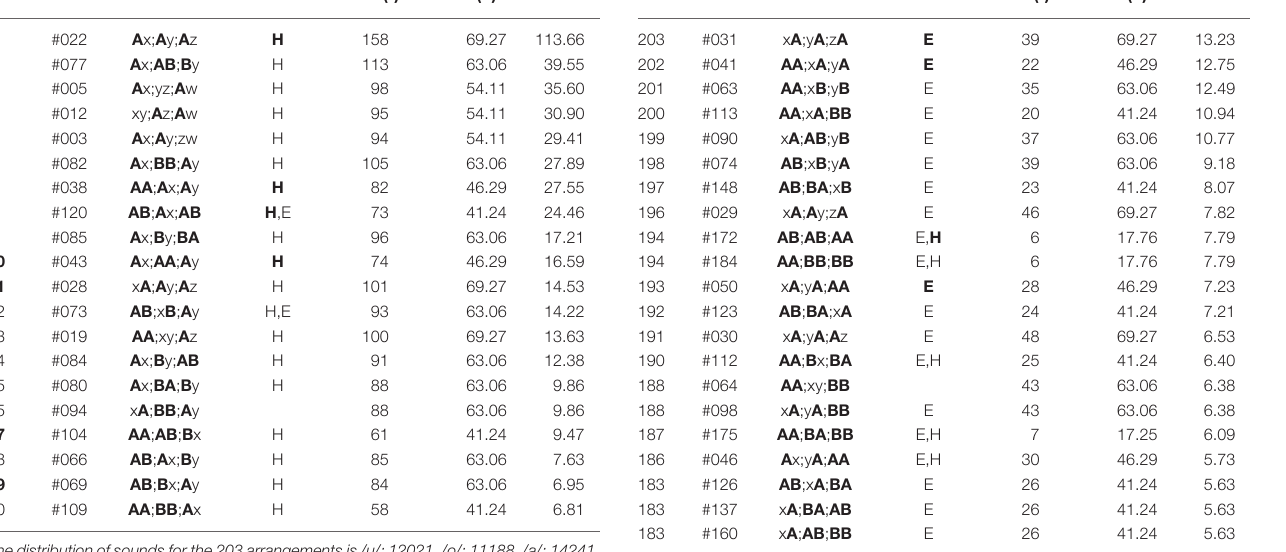
TABLE 4 | The bottom-twenty arrangements in The Complete Haiku Works of Shuoshi Mizuhara , wherein there are 9362 poems included. Expected (f - F) 2 / Rank No. Arrangement Correlation Surveyed ( f ) ( F ) F